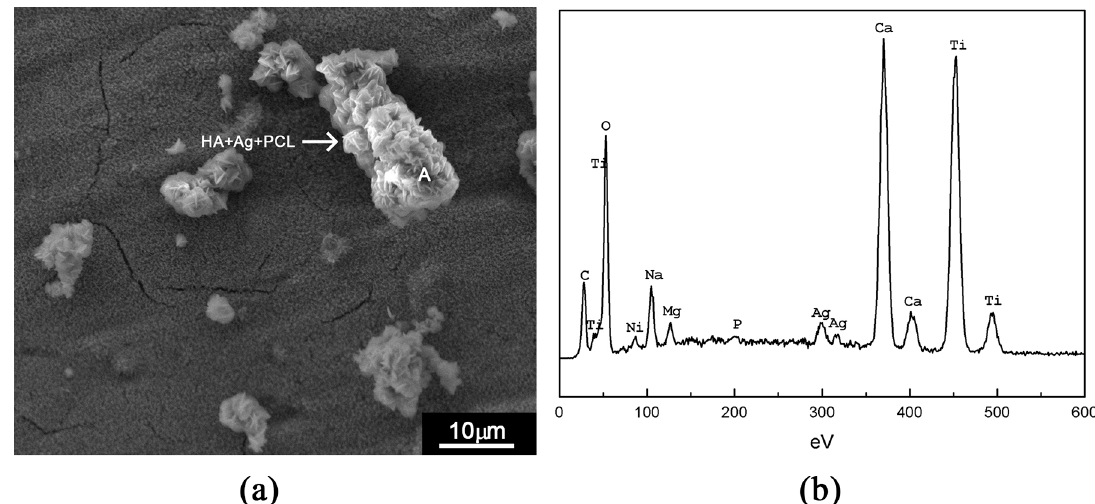
+ PCL. (b) Microanalysis obtained by EDX in region A. 3